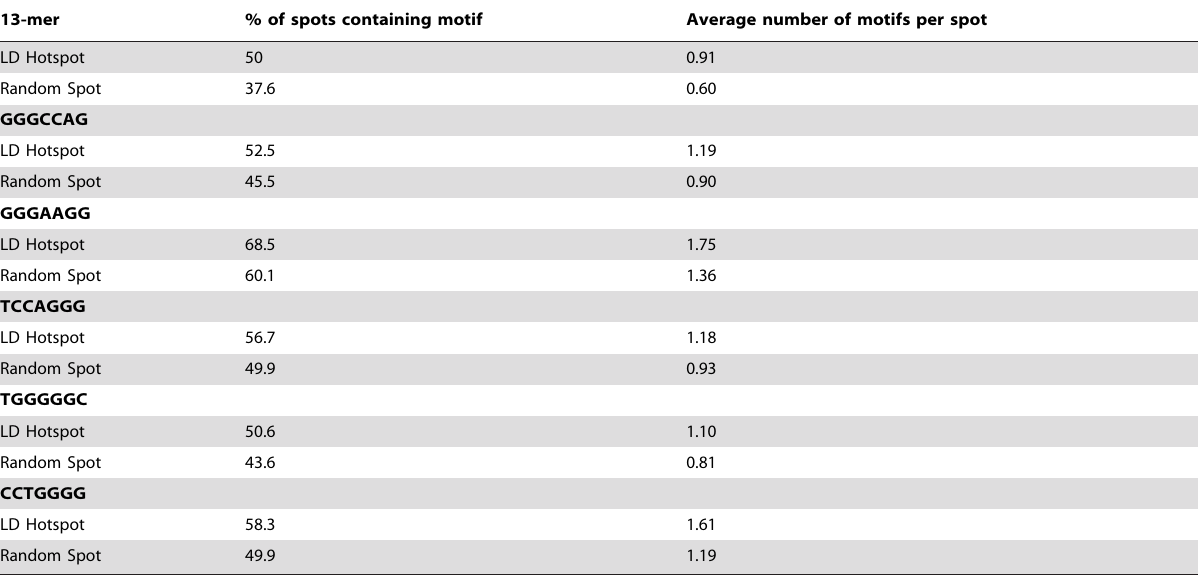
Table 3. Comparisons Between Motifs in LD-Defined Hotspots.